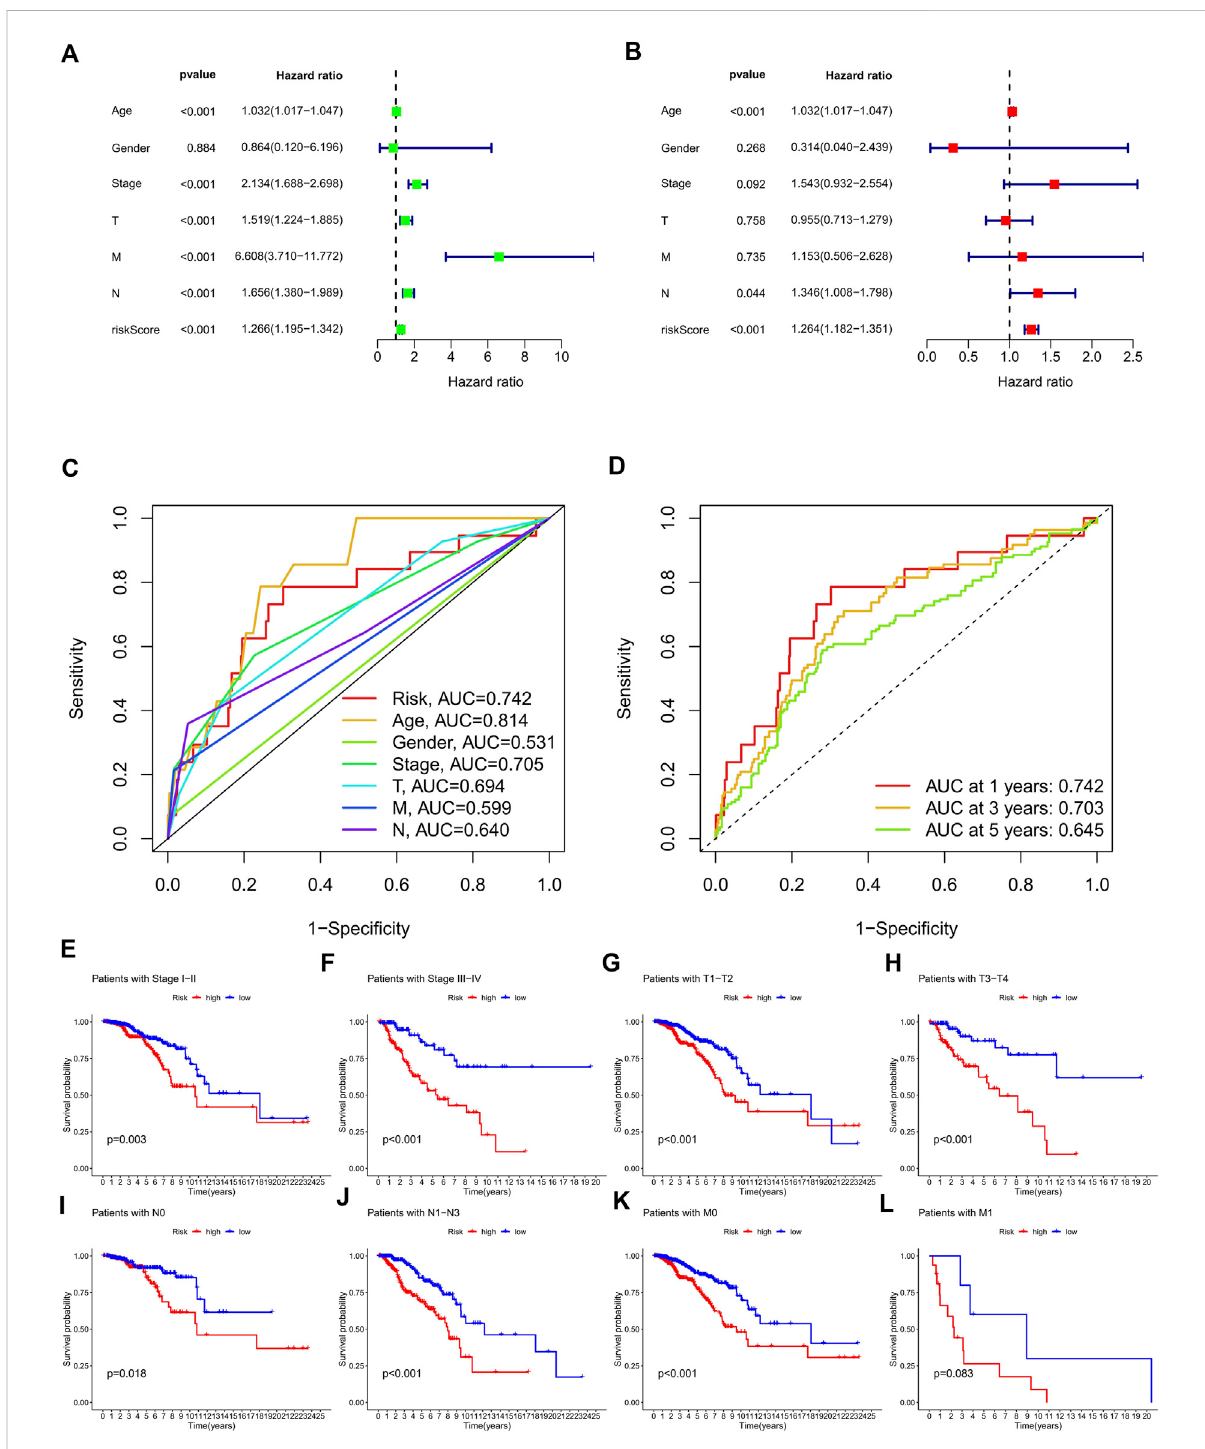
FIGURE 3 Validation of the ERS-related lncRNA prognostic signature and its relationship with clinicopathological characteristics. (A,B) Univariate (A) and multivariate (B) independent Cox regression analyses of the risk score and clinicopathological characteristics. (C) ROC curves and AUCs of the risk score and clinicopathological characteristics. (D) ROC curves and AUCs for 1-, 3-, and 5-year survival rates of the complete set. (E – L) Kaplan – Meier survival curves of BC patients ’ OS on the clinicopathological characteristics between two groups in the complete set. ERS, endoplasmic reticulum stress; AUC, area under the curve; ROC, receiver operating characteristic; OS, overall survival; T, tumor; N, lymph node; M,